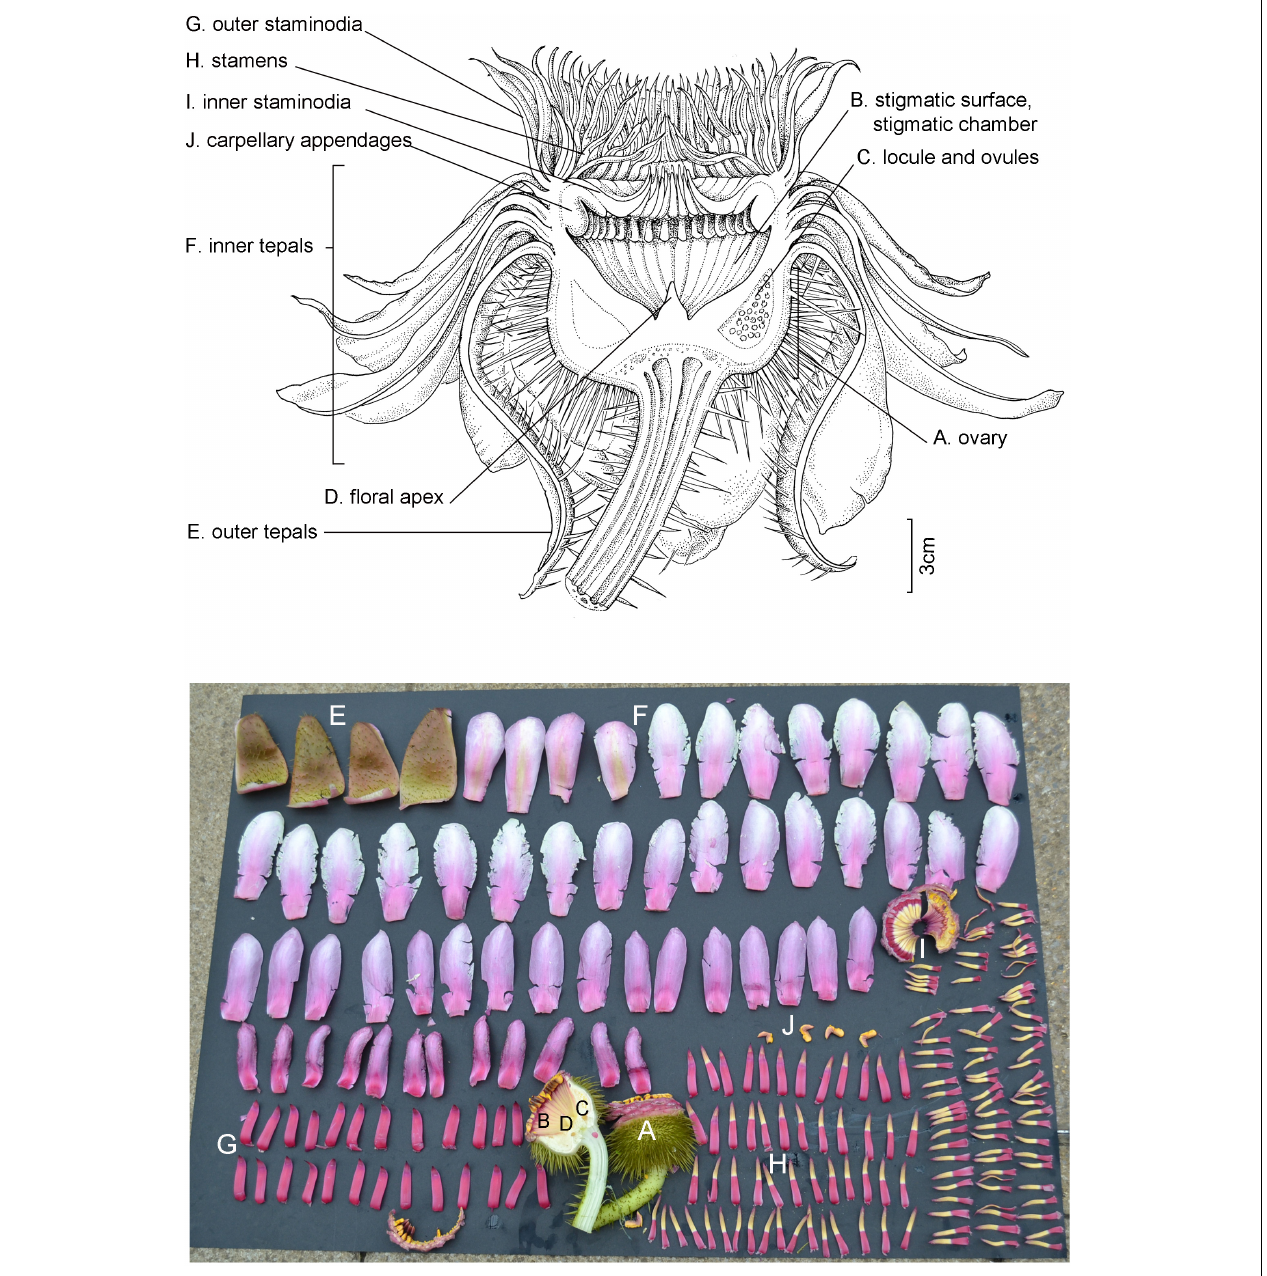
FIGURE 2 | Flower morphology and terms, using a Victoria amazonica second-night flower in longitudinal section for reference (above) and a fully dissected flower (below). (A) Ovary, (B) stigmatic surface and stigmatic chamber, (C) locule and ovules, (D) floral apex, (E) outer tepals, (F) inner tepals, (G) outer staminodia, (H) stamens, (I) inner staminodia, (J) carpellary appendages. Illustration and photo: Lucy T.